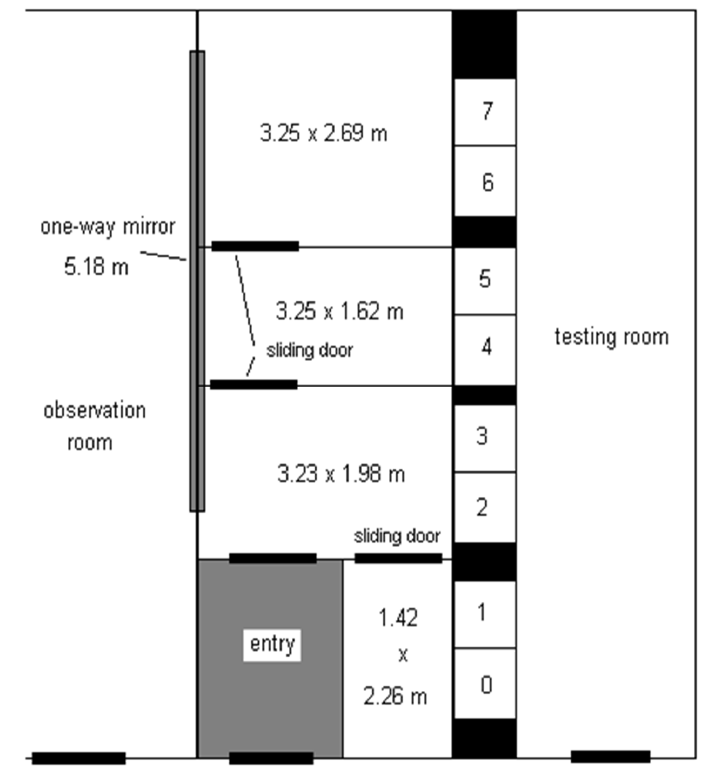
Figure 1. A scaled diagram of the enclosure and test cubicles.